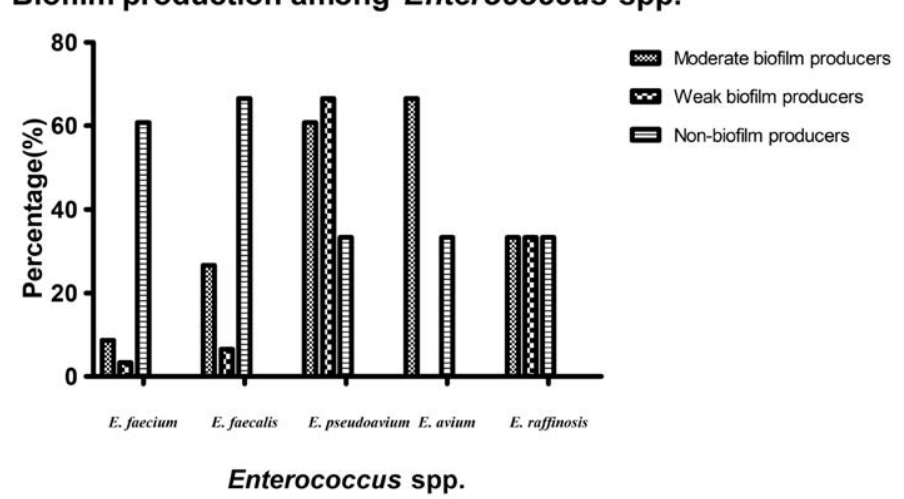
Fig. 1. Biofilm formation ability of Enterococcus spp. included in the